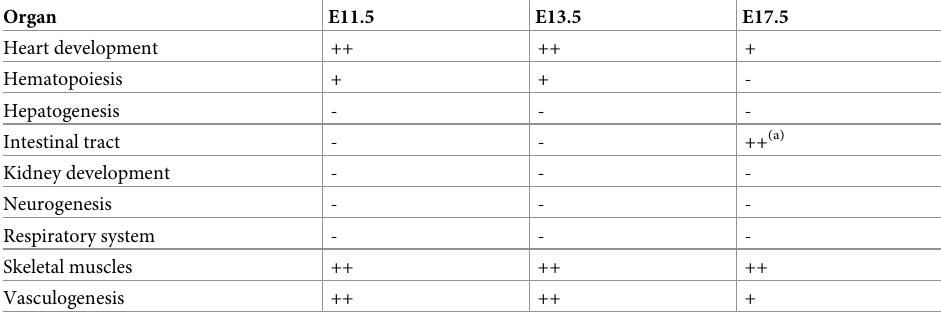
Table 1. Summary of the expression analysis of Jmjd1c during embryogenesis. Organ E11.5 E13.5 E17.5 Heart development ++ ++ + Hematopoiesis + + - Hepatogenesis - - - Intestinal tract - - ++ (a) Kidney development - - - Neurogenesis - - - Respiratory system - - - Skeletal muscles ++ ++ ++ Vasculogenesis ++ ++ + Sections of beta-galactosidase stained embryos were evaluated for beta-galactosidase intensity in the different tissues during embryonic development. Representative sections are illustrated in Fig 1 and S6 Fig. No expression (-), weak expression (+), strong expression (++). (a) Staining signal in the intestine at time point E17.5 is caused by background beta-galactosidase activity (S6E